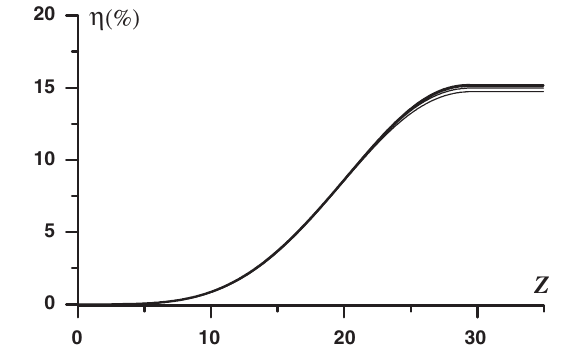
FIG. 7. FEL with a reversed guide field. Dependence of electron efficiency on longitudinal coordinate (for parameters given in Fig. 6) for the beam fractions with different initial parasitic transverse velocity at the entrance of the interaction space. The maximum initial parasitic transverse velocity equals 50% of the operating transverse velocity.